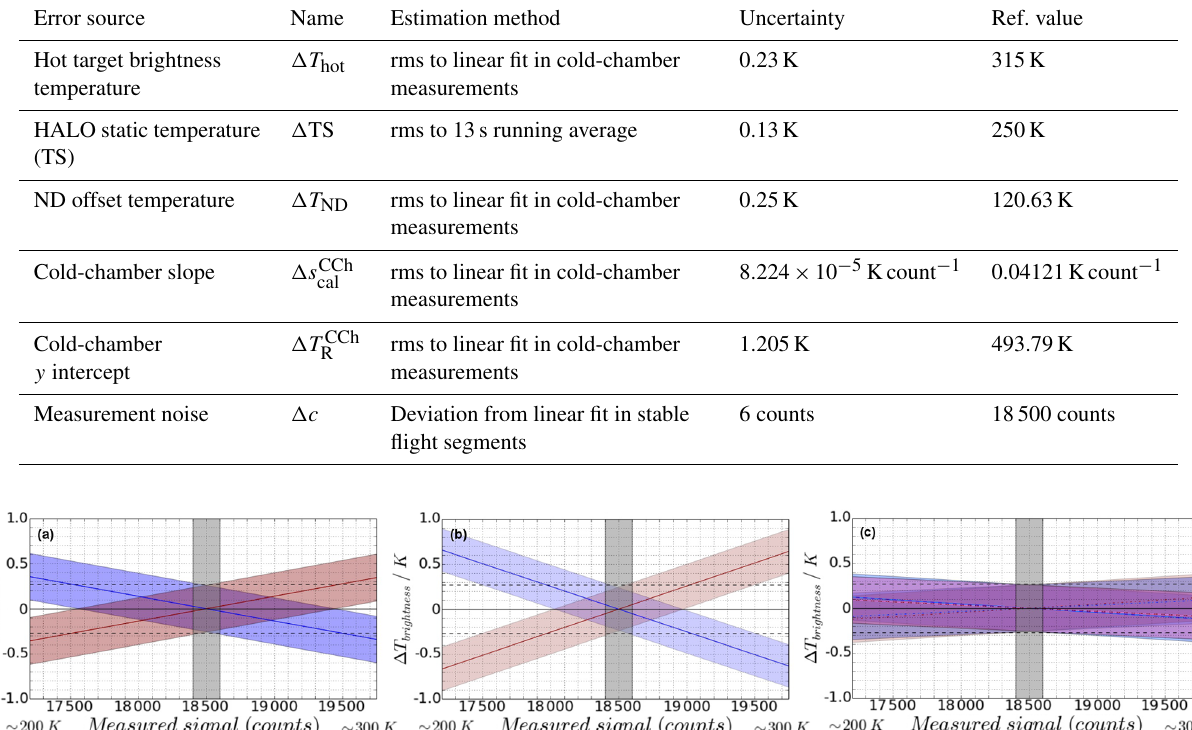
Figure 12. Error estimation of calibration methods with the applied HALO TS (assumed to be at 250K) offset correction for the calibration methods (a) noise diode + hot target, (b) hot target + HALO TS, and (c) using cold-chamber calibration parameters. The measurement error for an individual measurement is indicated by the uppermost and lowermost edges of the blue or red shaded region (caused by measurement noise). Vertical grey shaded region: expected range of measurement signals if the 0 ◦ measurement signal is at 18500 counts ( ≈ 250K). Black dashed horizontal lines: expected error induced by measurement noise of 6